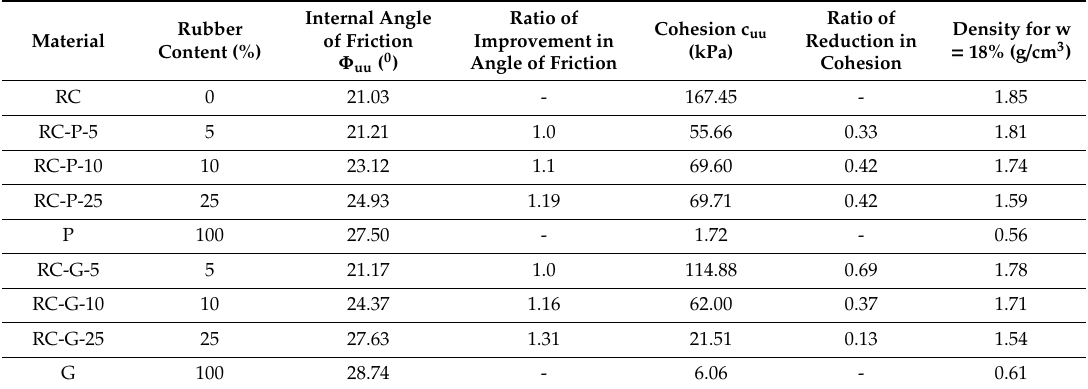
Table 3. Results of strength parameters Φ uu and c uu and of density ρ determination for studied materials obtained for moisture content w = 18%.